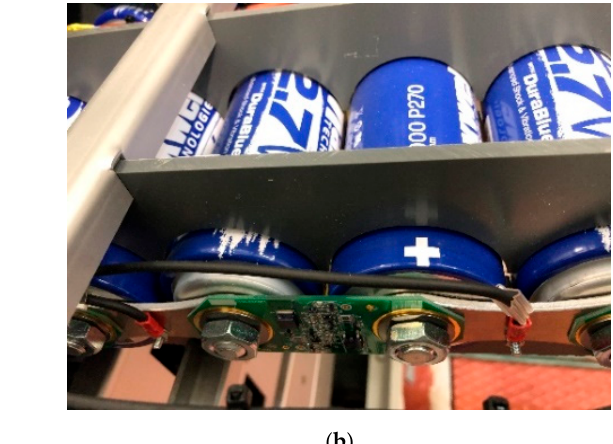
Figure 5. ( a ) Power loss map in the voltage balancing system as a function of current and voltage and ( b ) detail of the connection plates between the cells and of the voltage balancing system.